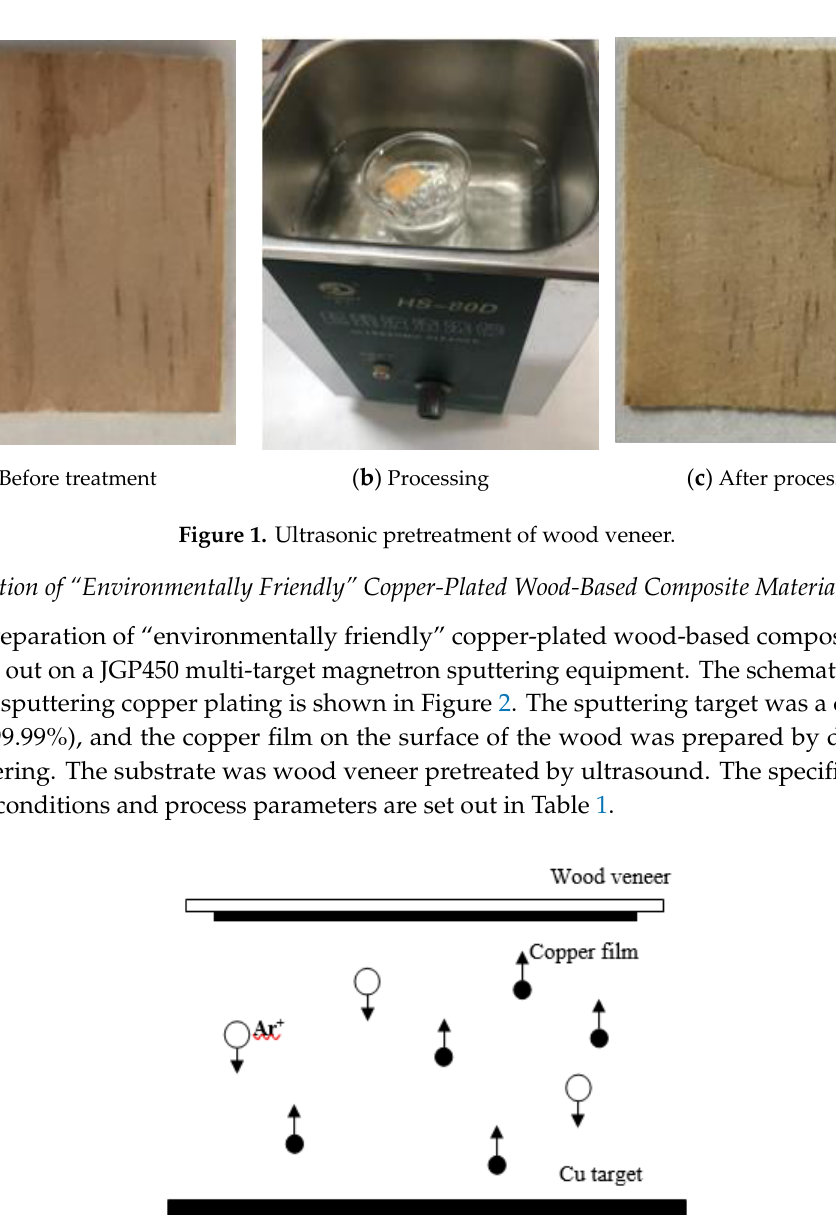
Figure 2. Schematic diagram of magnetron sputtering copper plating.